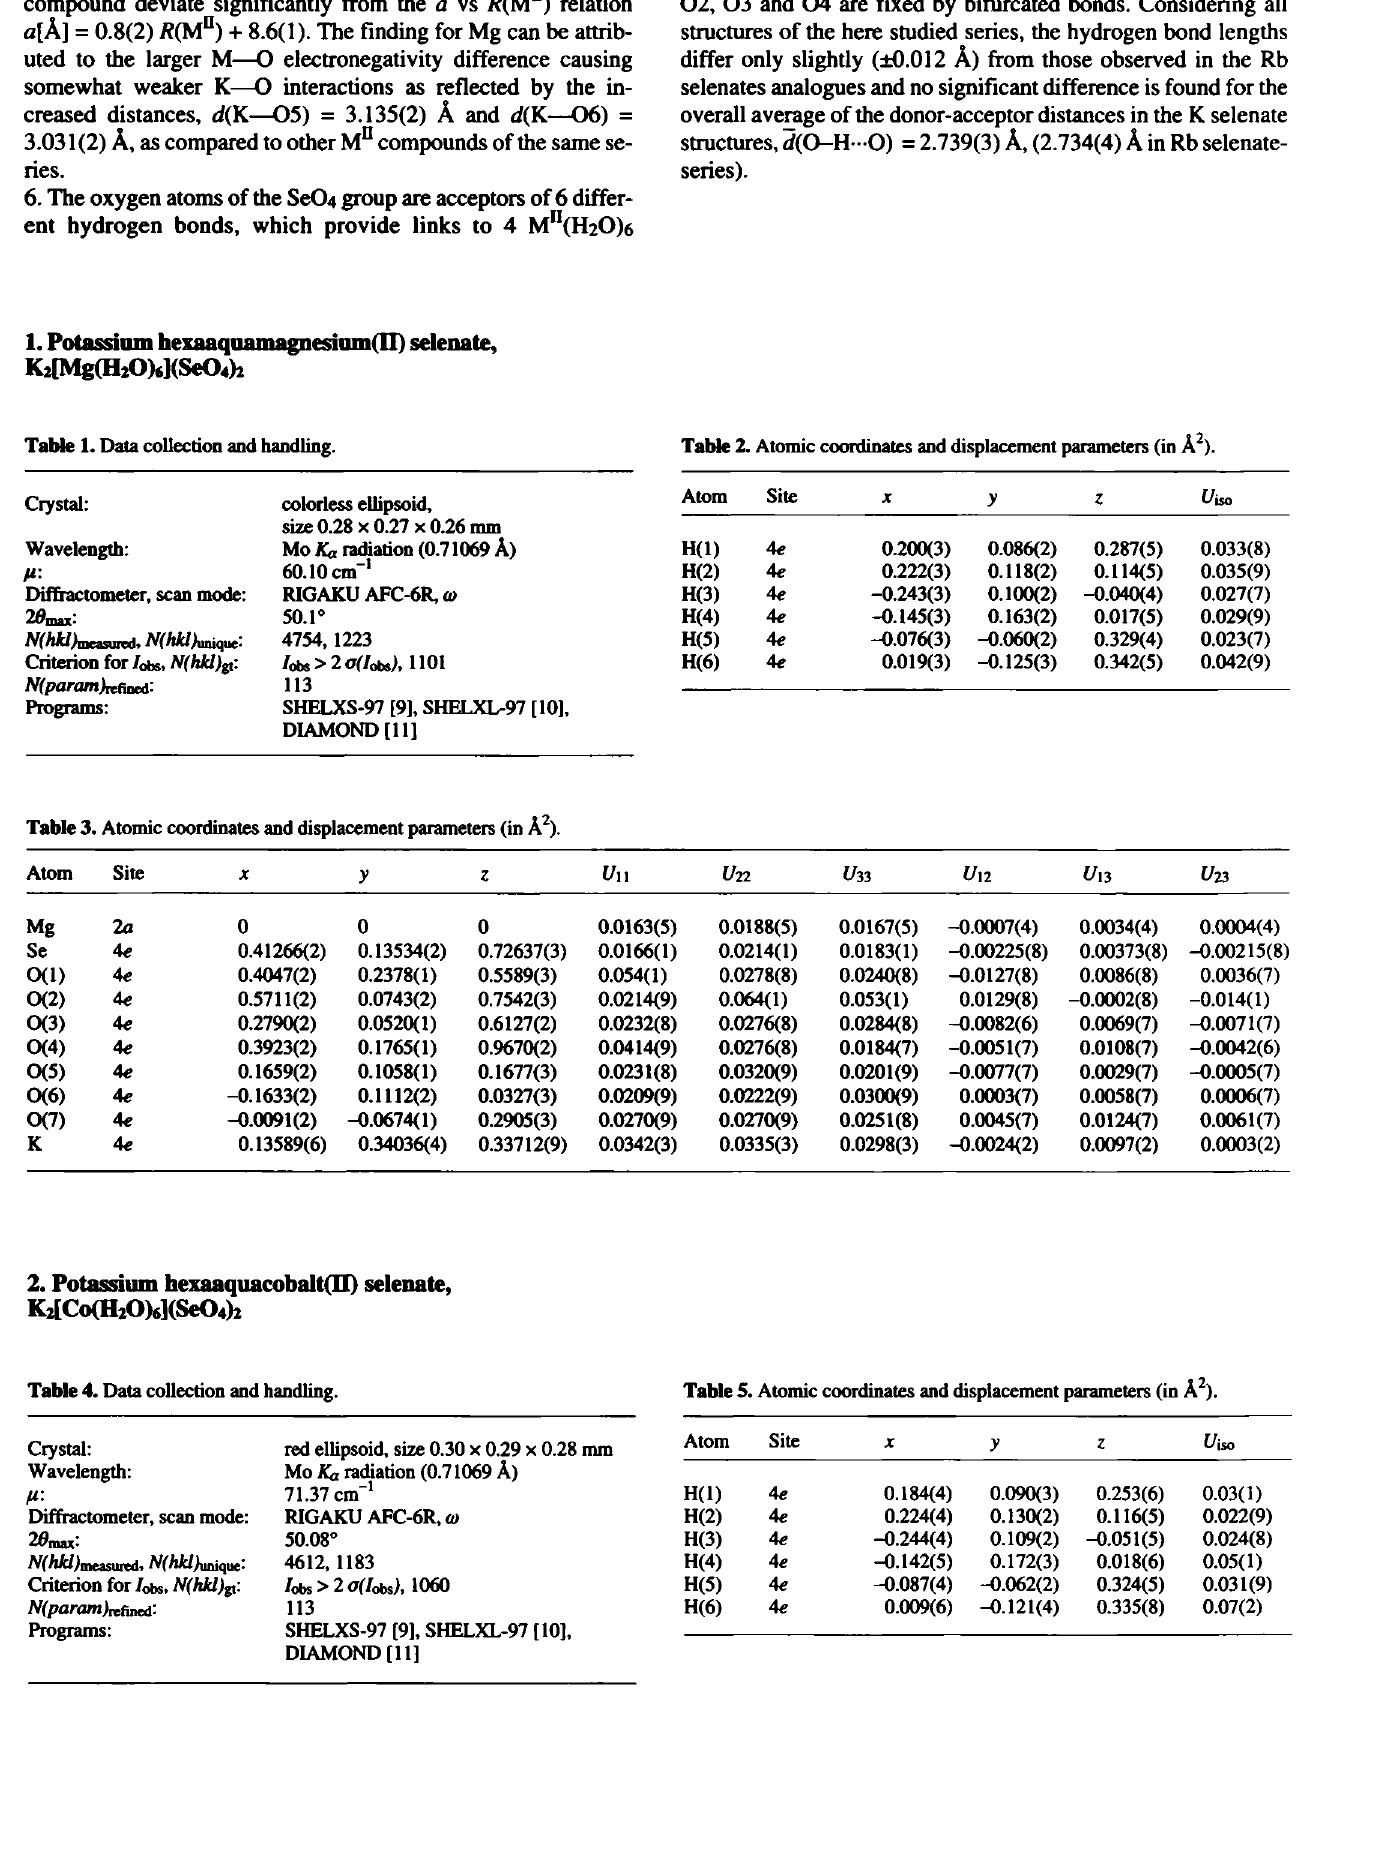
Table 4. Data collection and handling. Table 5. Atomic coordinates and displacement parameters (in Â 2